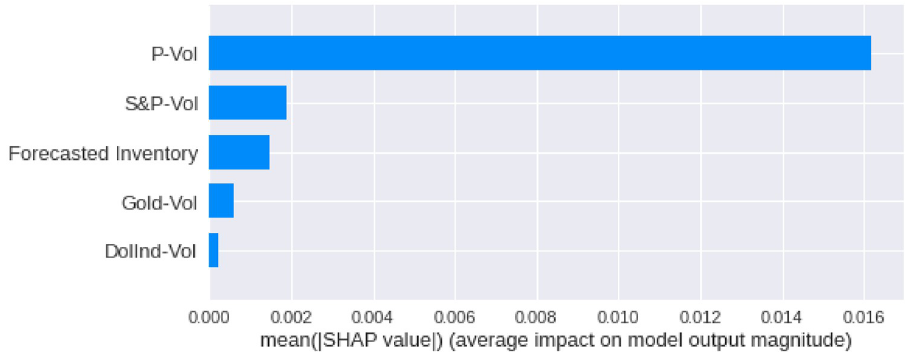
Fig 25. Mean Shapley values for the fifth previous day using Nadam